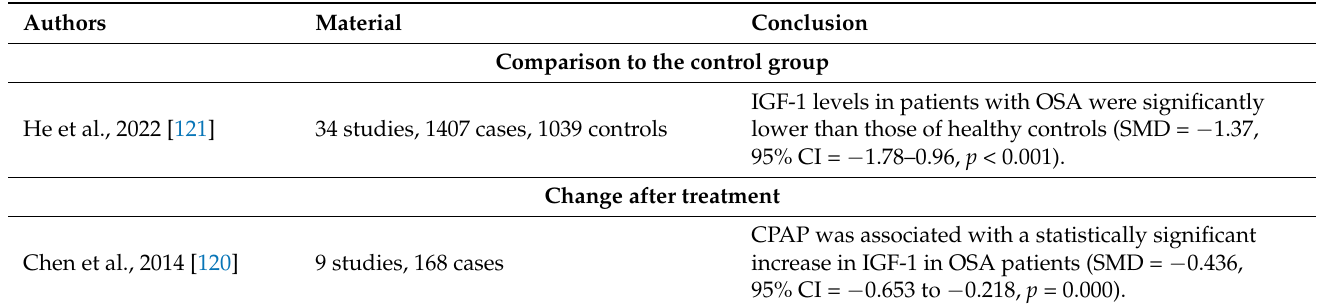
Table 12. Meta-analyses of IGF-1